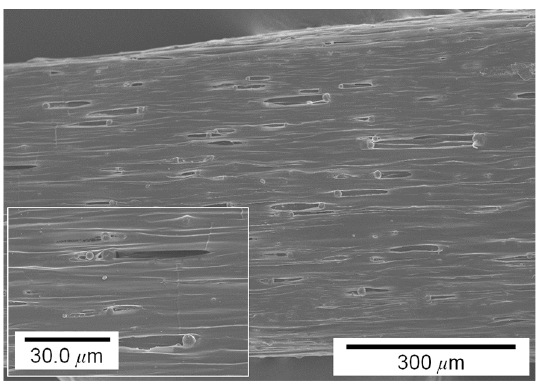
Figure 11. Surface morphology of the area close to the fracture of a test specimen after tensile test.